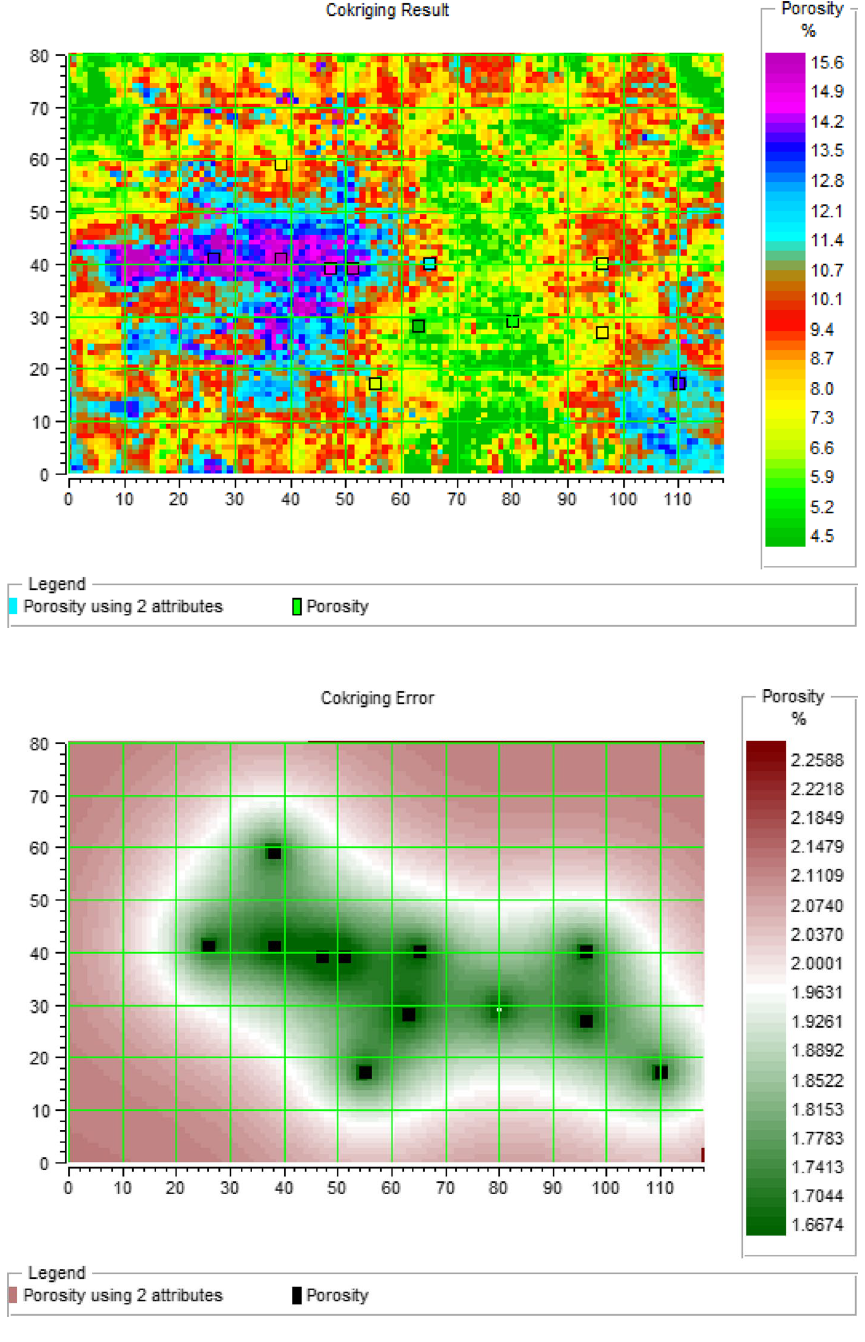
Fig. 36 Result of geostatistical estimation of porosity on the one page for the third category of data